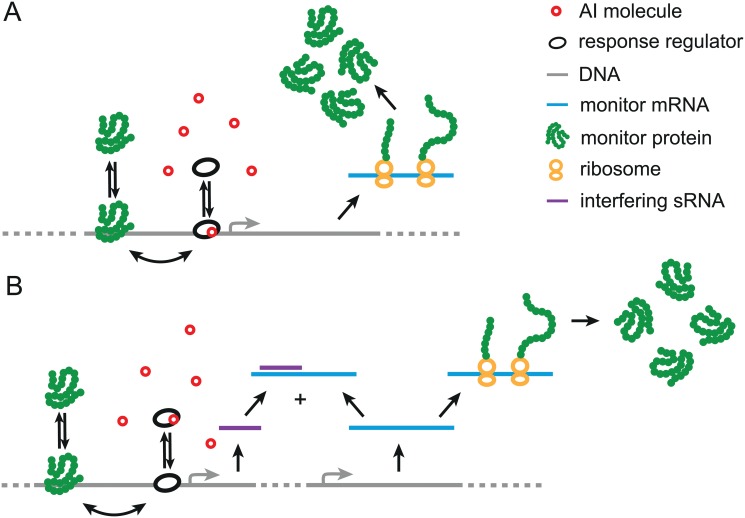
Models for the regulation of the monitor protein (MP) expression.
A. In the TF regulation model, AI molecules induce the production of MPs by allosterically regulating the transcription factor (TF), which only binds to its cognate DNA regulatory sequence when complexed with AI. B. In the sRNA regulation model, a TF positively regulates a small regulatory RNA (sRNA) that represses MP expression. In both models, the expression of MP is positively regulated by binding of AIs to the TF and MP proteins regulate their own expression. For strong sRNA-mRNA pairing, sRNA regulation reduces the stochasticity in MP expression compared with TF regulation. The internal feedback regulates the transcription of the MP mRNA for TF regulation, whereas it regulates the sRNA level for sRNA regulation.